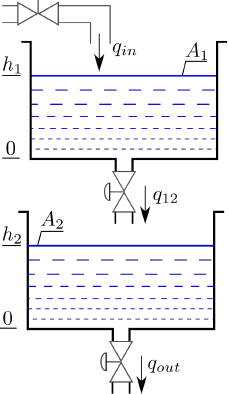
Figure 3. A physical model of the cascaded configuration of a two-tank system with one inlet and two outlets, see